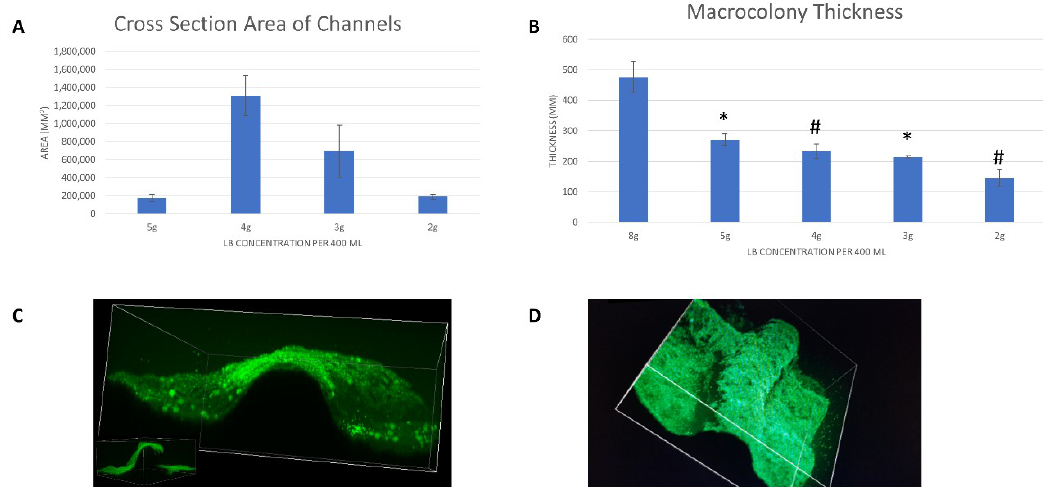
Figure 4. Volumetric analysis of channels. ( A) Cross-section area of channels, approximated by the integral of a fitted parabola; ( B ) Macrocolony thickness; ( C ) A direct view into a single channel, demonstrating its parabolic structure; ( D ) A top-view of a single channel, at the interface with another channel perpendicular to it. Statistical significance is in relation with the values obtained by colonies grown on non-depleted nutrient medium (8 g LB / 400 mL), where * indicates p < 0.05, # indicates p < 0.01. The results shown are means ± standard deviations (SD) of six independent experiments. General formula of a polynomial of a second degree: f ( x ) = ax 2 + bx + c . Coordinates of channel “peak”: ( x 1 , f ( x 1 )) = ( 0, h )